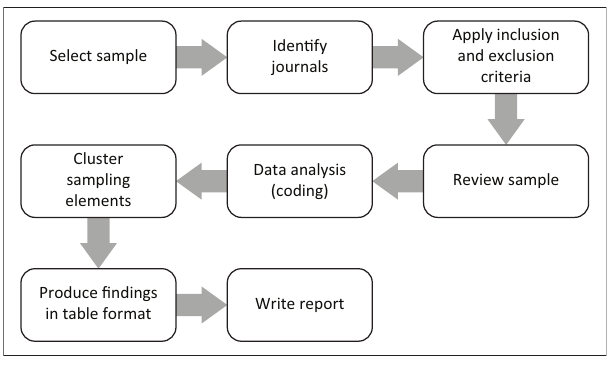
FIGURE 1-A1: Systematised review design